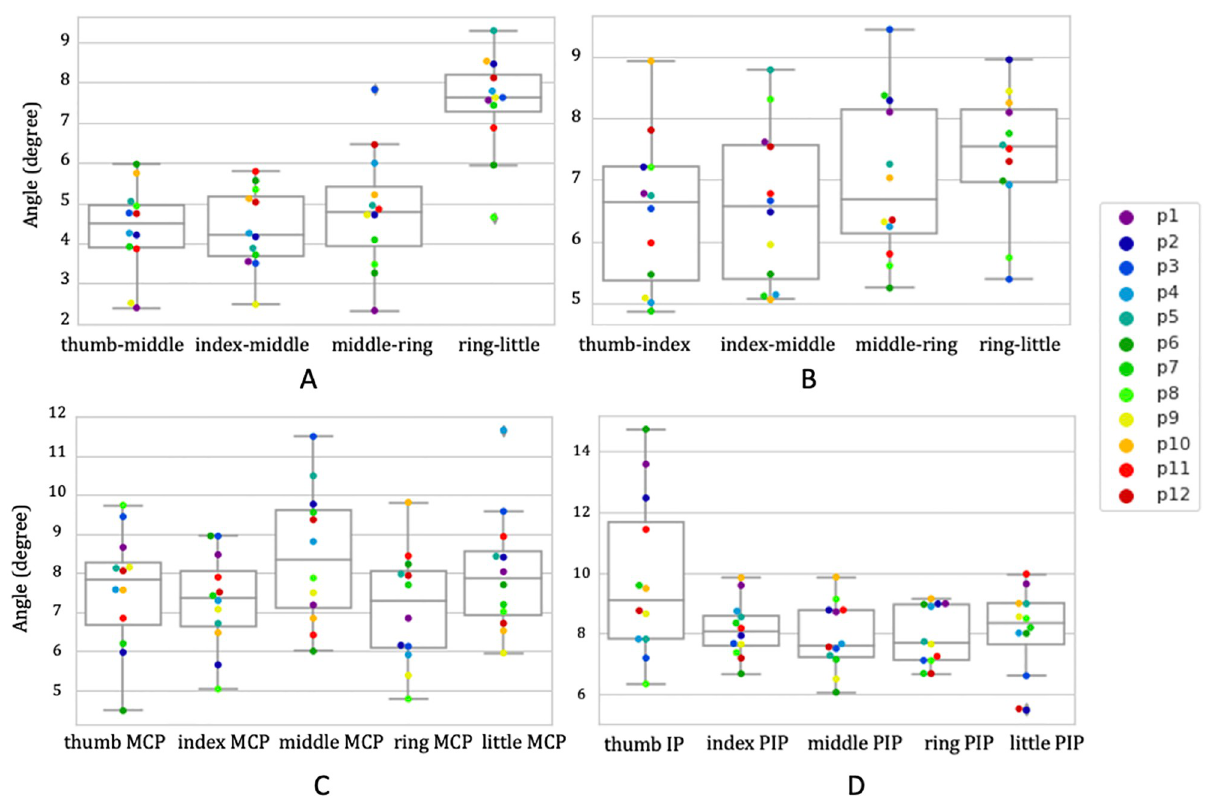
Fig 9. RMSEs for the four activities. Root mean square error (RMSE) differences between OpenPose on monocular images and marker-based optical motion capture system during A) finger abduction and adduction, B) radial walking, C) finger metacarpophalangeal flexion, and D) thumb opposition. Each colour represents a different